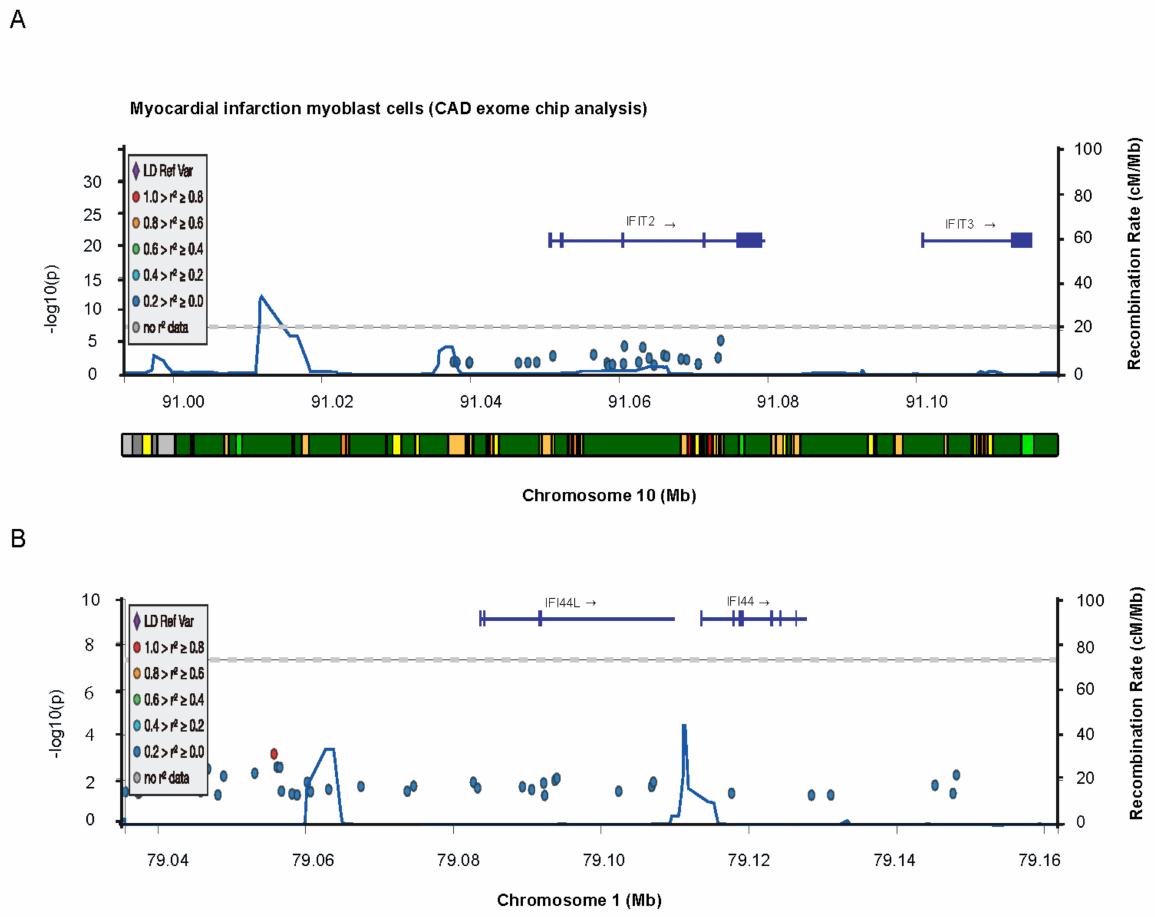
Figure 6. Blast signature genes in the Cardiovascular Disease Knowledge Portal Project Database. The GEnomic region Miner (GEM) module explore target gene variant associations, epigenomic annotations, and credible sets across chromosome. Ifit2 and Ifit3 are located on chromosome 10 ( A , B ) and Ifi44l is located on chromosome